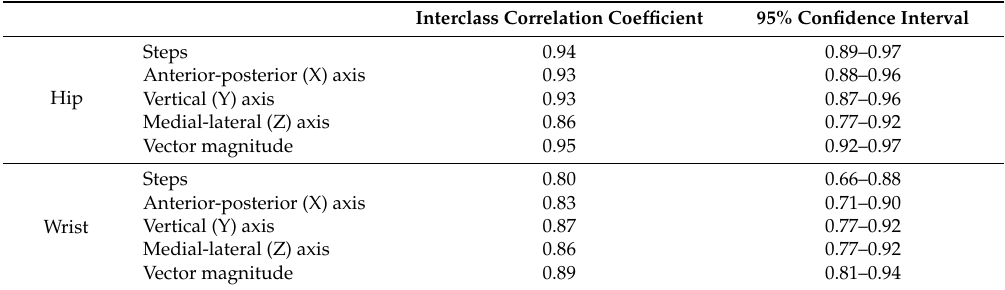
Table 1. Interclass correlation coefficient between GT9X and wGT3X in steps and activity counts.